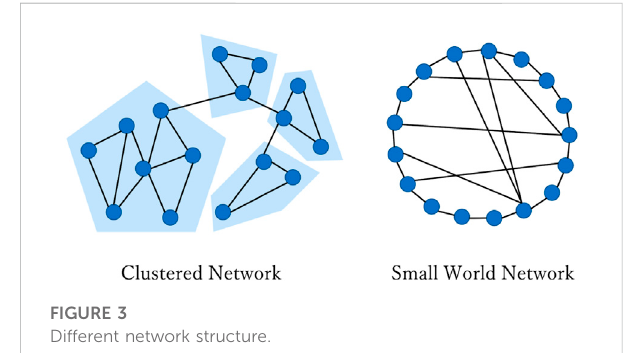
FIGURE 3 Different network